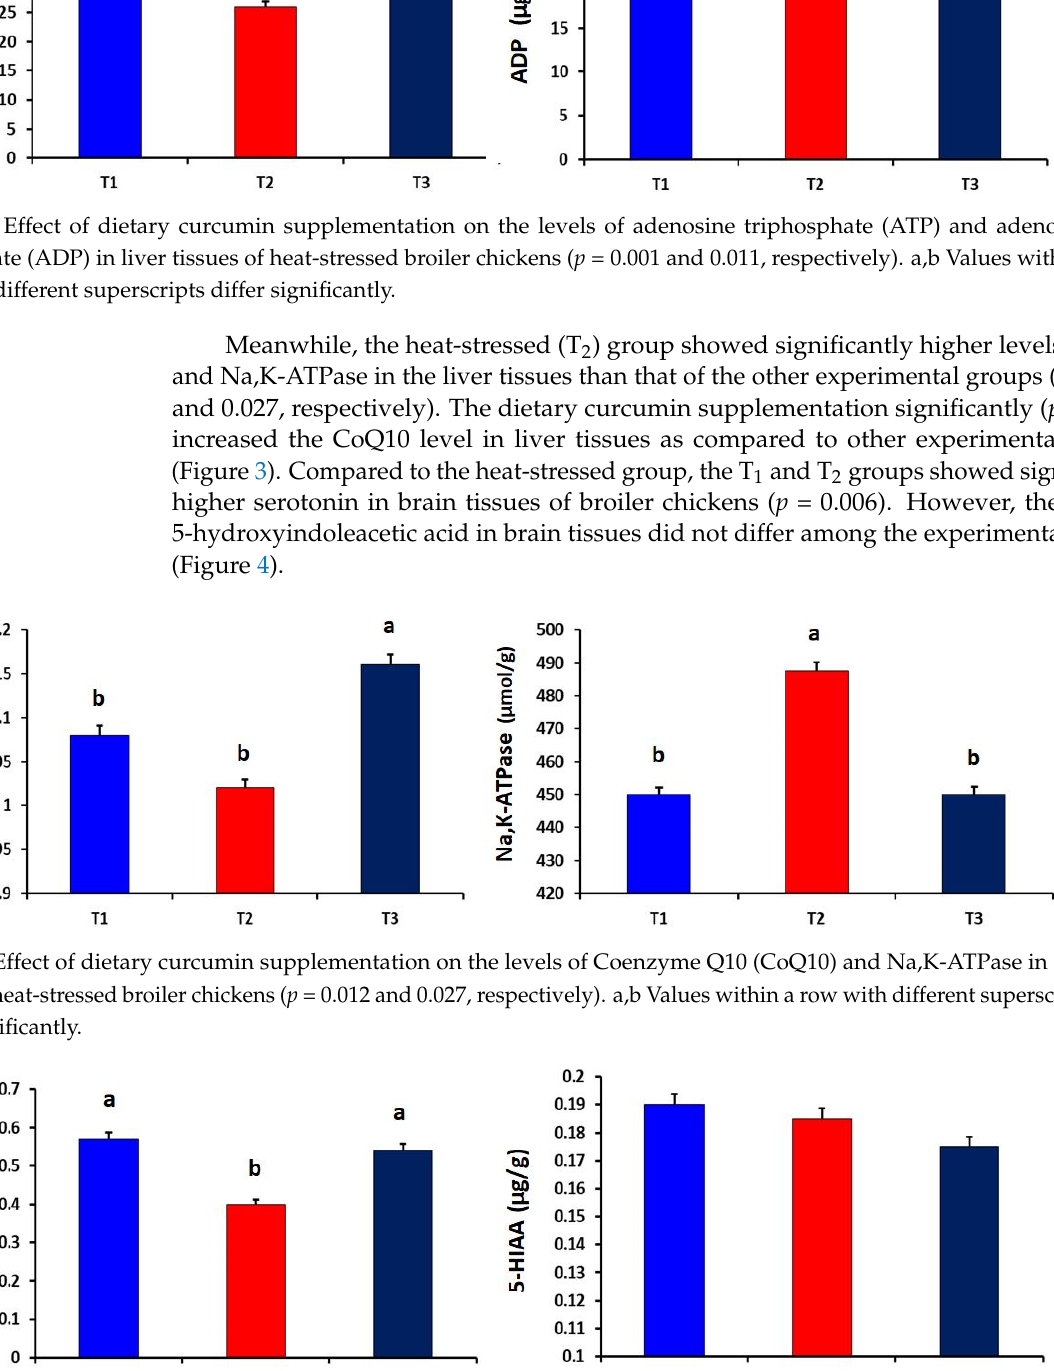
Figure 1. Effect of dietary curcumin supplementation on the levels of malondialdehyde (MDA) in the breast and thigh muscles of heat-stressed broiler chickens ( p = 0.001 and 0.015, respectively).